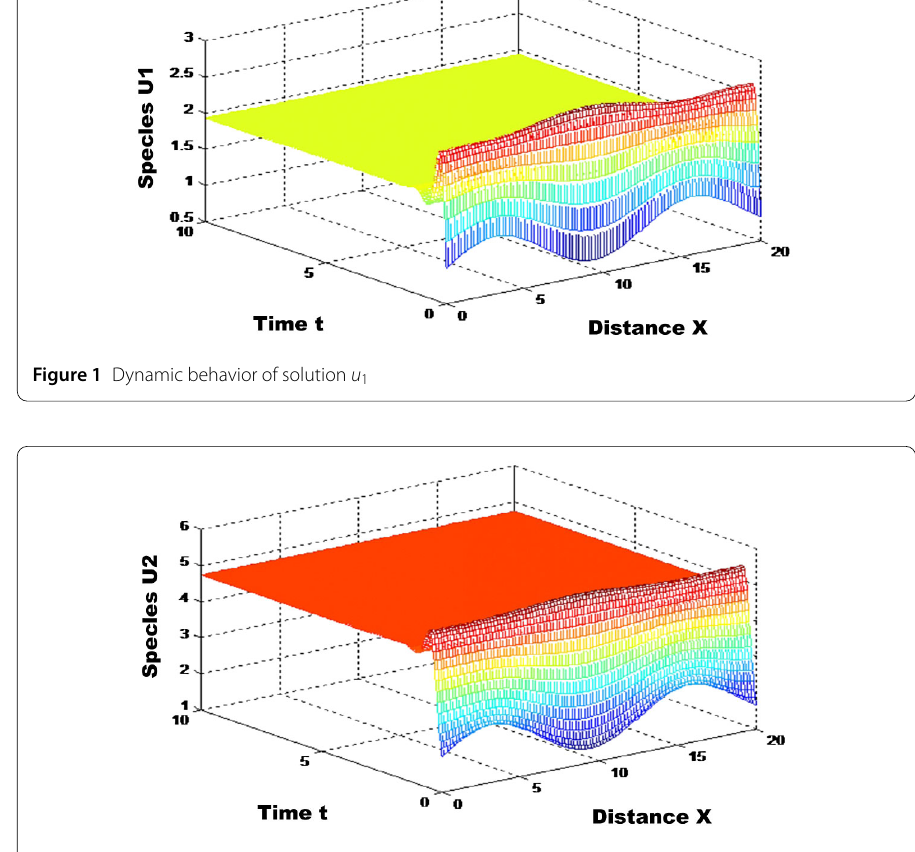
Figure 2 Dynamic behavior of solution u